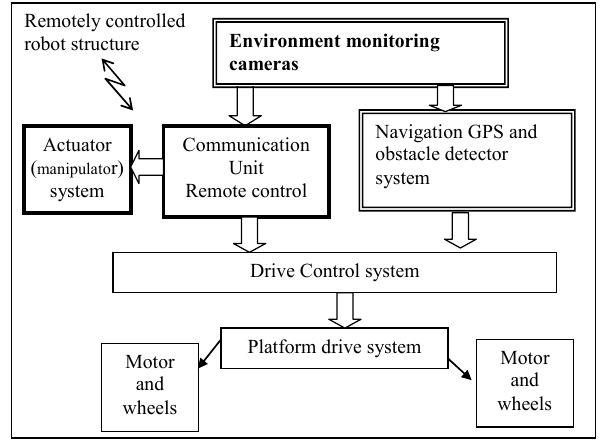
Figure 1. The basic model of a remotely controlled robot.